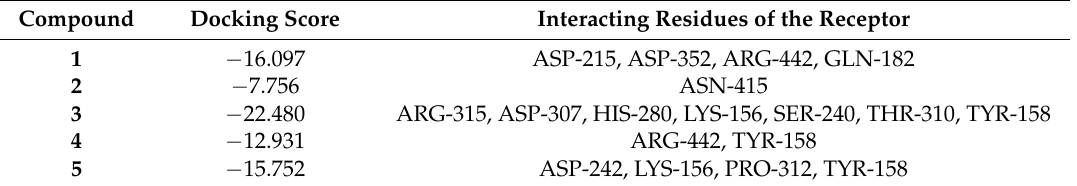
Figure 4. Represents the 3D structures of Compound 2 showing binding potential. Red color in the image shows position of oxygen, green benzene ring, white hydrogen atom, brown color indicates amino acid sequence and blue color indicate nitrogen or amino group. Table 2. Molecular docking score of the test compounds with interacting amino acids of the active site of α -glucosidase enzyme.